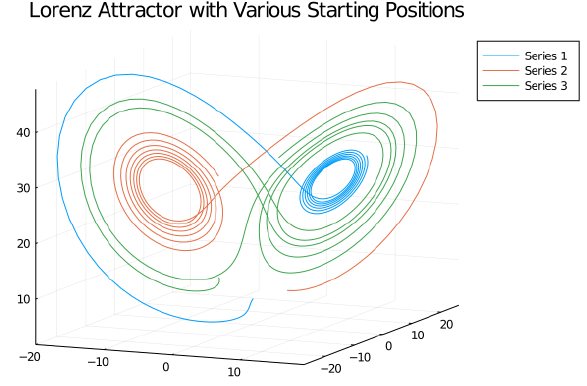
Figure 4. Impact of initial conditions on the Lorenz